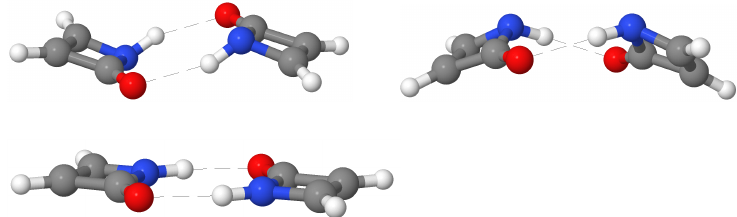
Figure 9. Different isomers of the AZH (DCR) dimers: bent–trans, bent–cis,